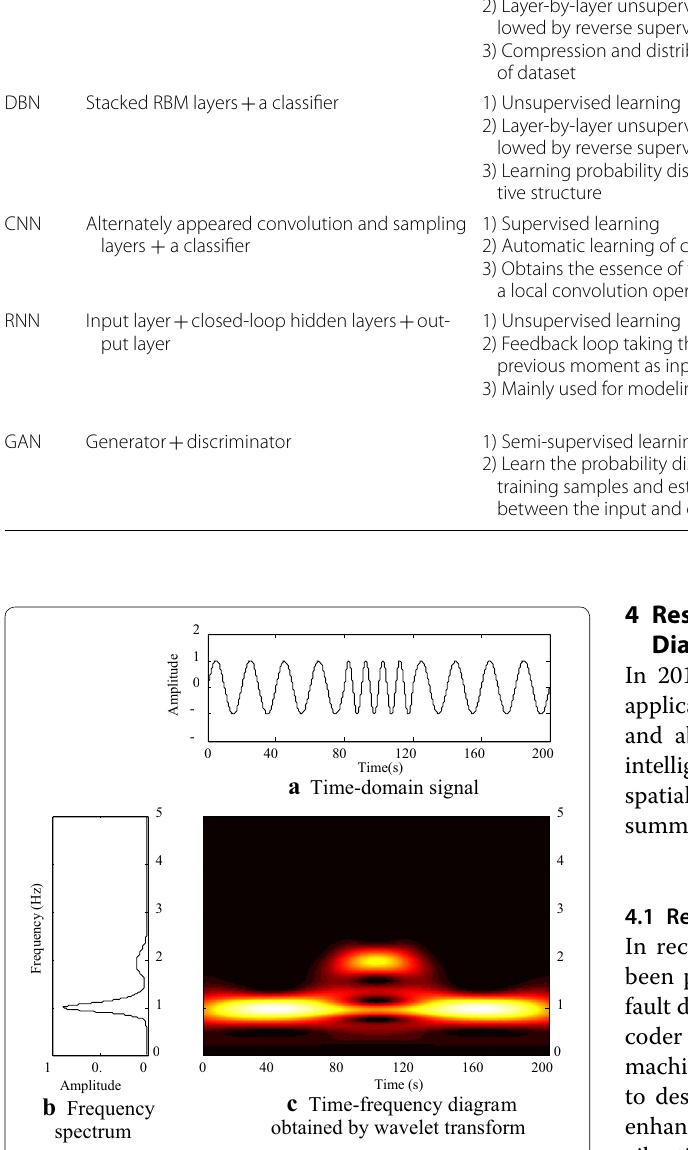
Figure 10 Possible forms of input when DNNs are used in a hydraulic fault